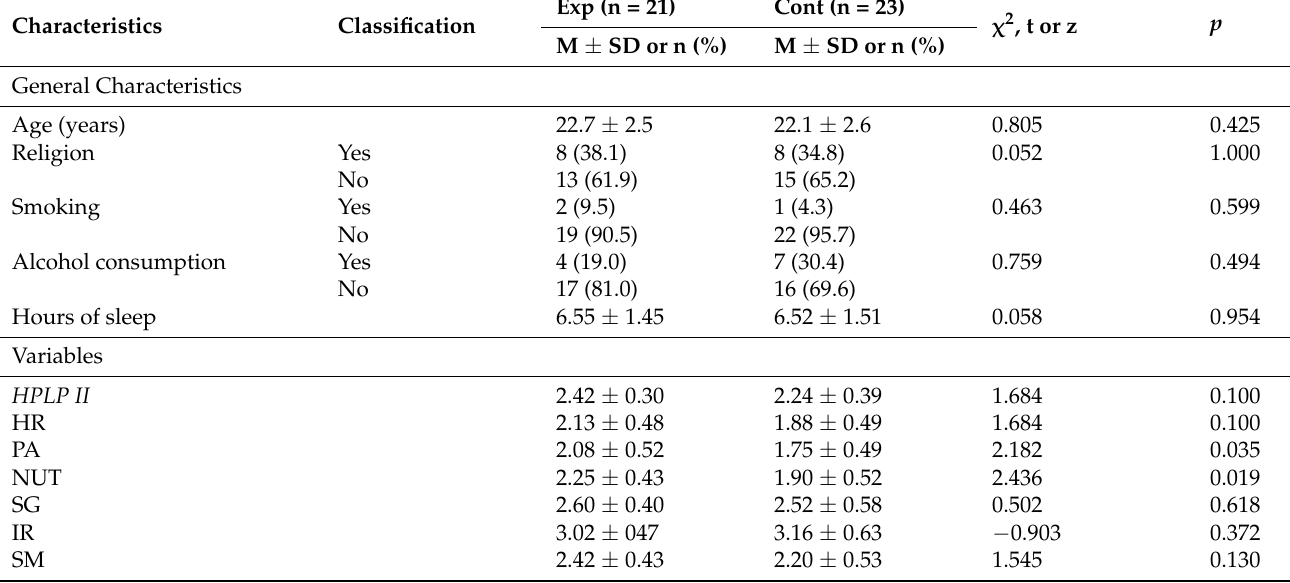
Table 2. Homogeneity test for participant characteristics and variables in the experimental and control groups (N = 44).